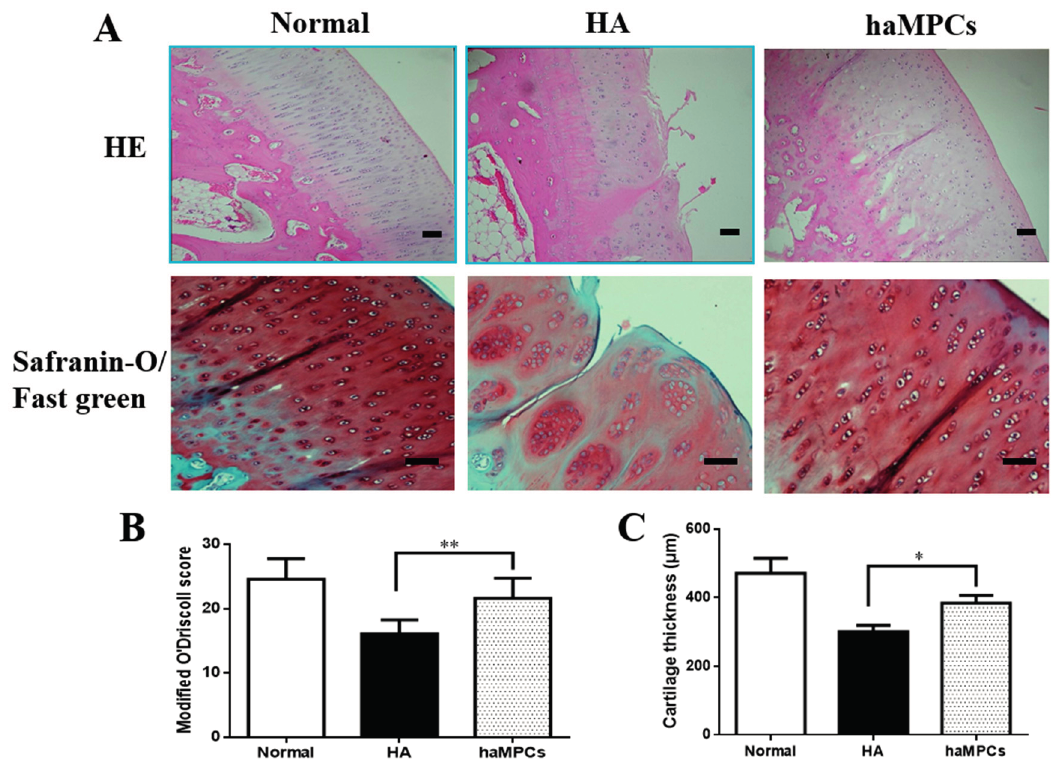
Figure 4. Histological findings. ( A ) HE and Safranin-O/Fast green stainings showed that haMPC treatment alleviated fissures and cracks formation; ( B ) The modified O’Driscoll histological score showed that haMPC treatment had significantly higher score compared with HA group; and ( C ) The haMPCs significantly increased cartilage thickness compared to HA group. Scale bars = 50 μ m. * indicates p < 0.05; ** indicates p <